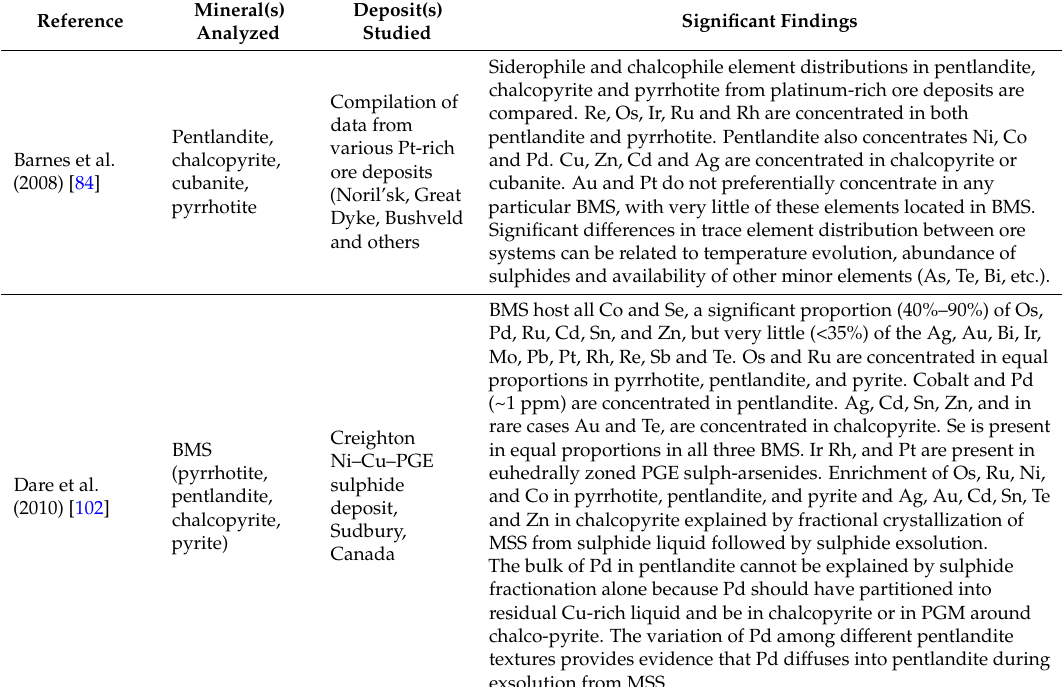
Table 3. Selected examples of LA-ICP-MS studies of trace element distribution in minerals from orthomagmatic ore